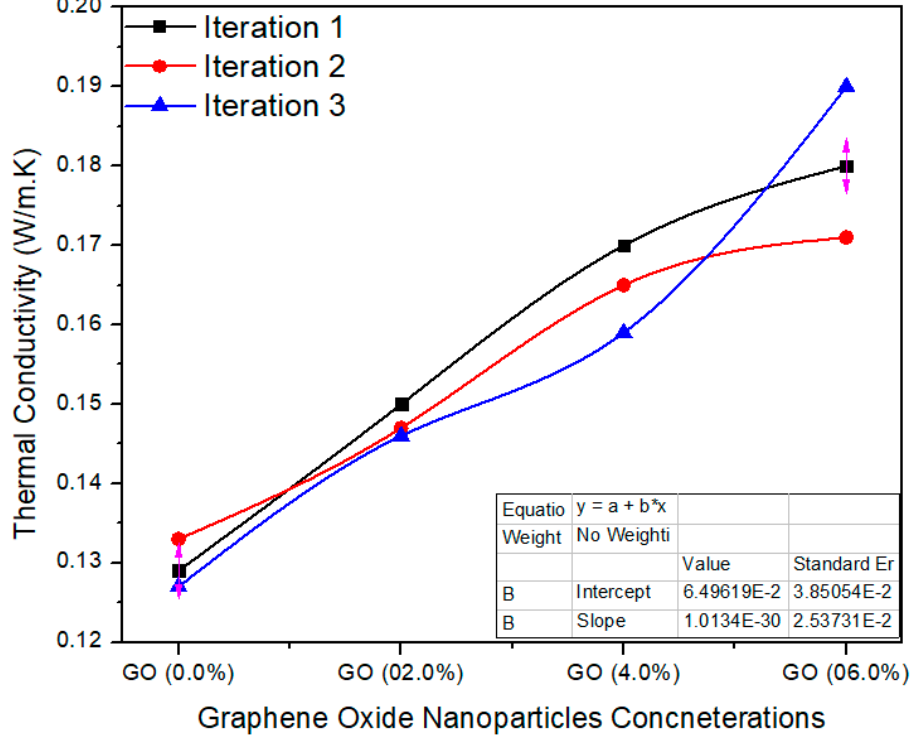
Figure 11. Thermal conductivity of a number of treatments of final MDF with GO.